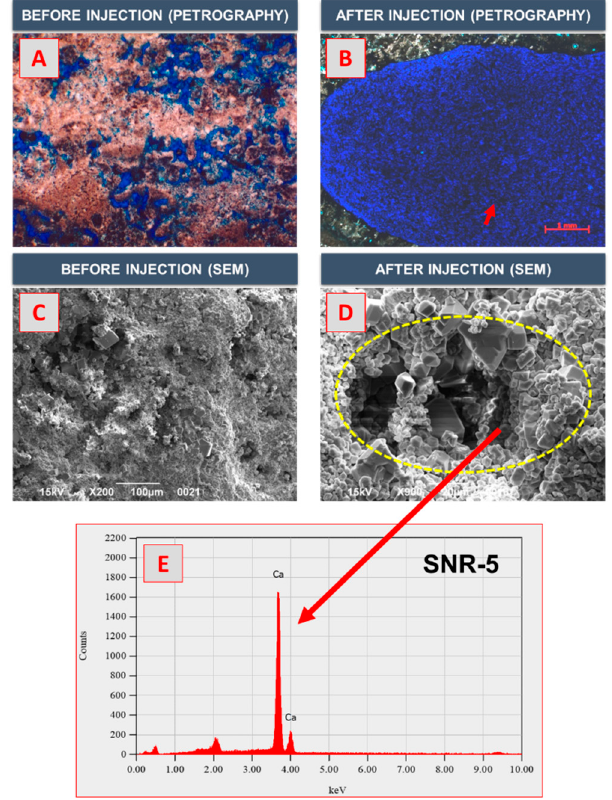
Figure 9. Results of SEM–EDX and thin-section analyses of SNR-5.